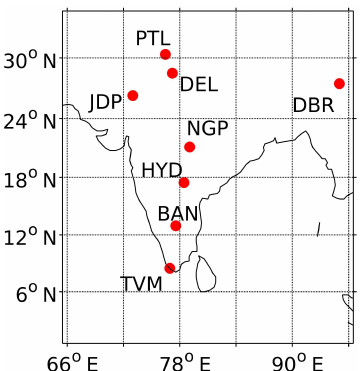
Figure 2. Locations of the ground stations, radiosonde measure- ments from which are used for the purpose of validating PBLH de- rived by MERRA-2. These subregional representative stations form a subset of ground-based observatories, AOD and BC mass concen- tration measurements from which are employed for construction of assimilated AOD and AAOD